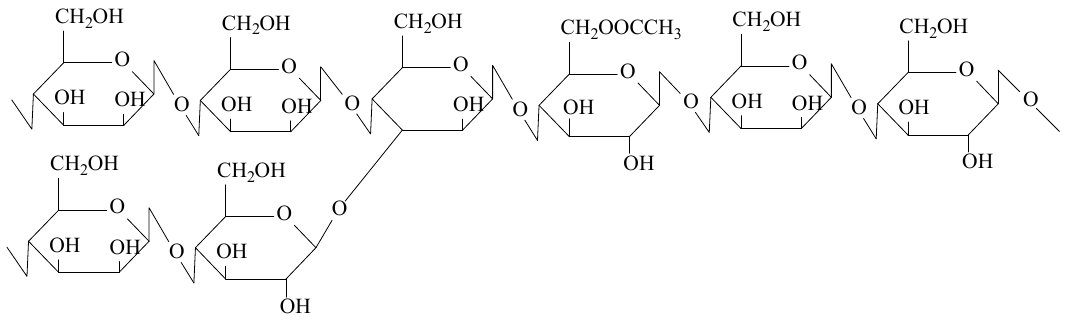
Figure 1. The structure of KGM.